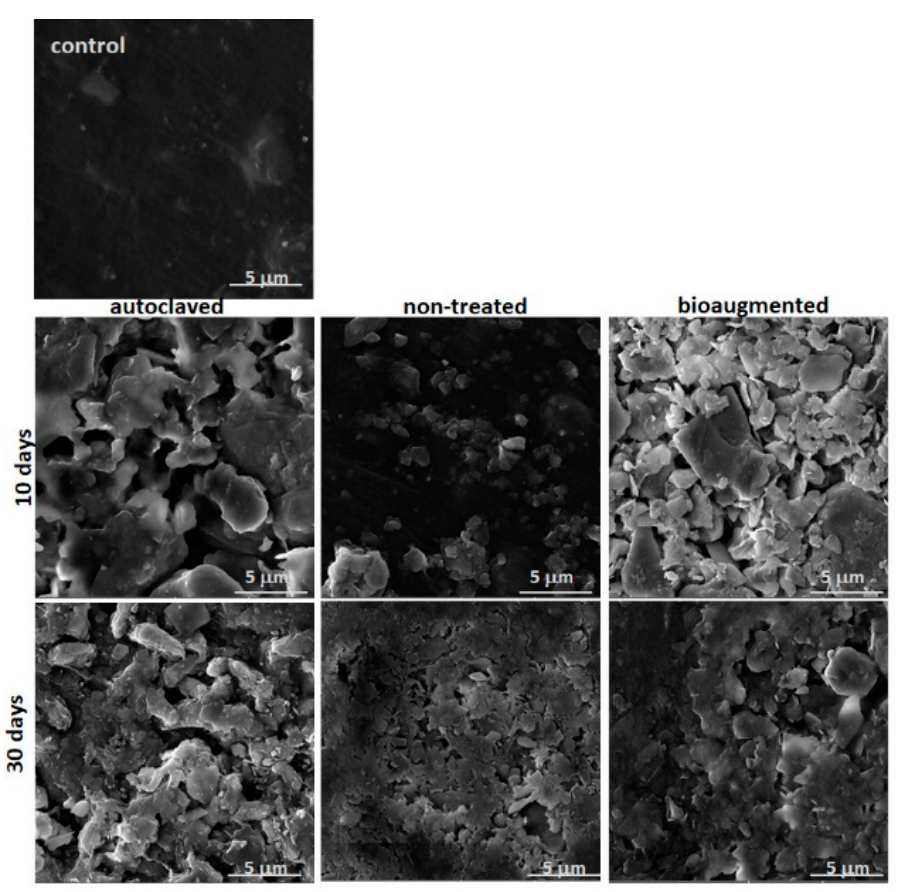
Figure 8. SEM images of PVA/TPS films after 10 and 30 days of composting under different condi- tions (magnification of 10,000×). tions (magnification of 10,000 ×